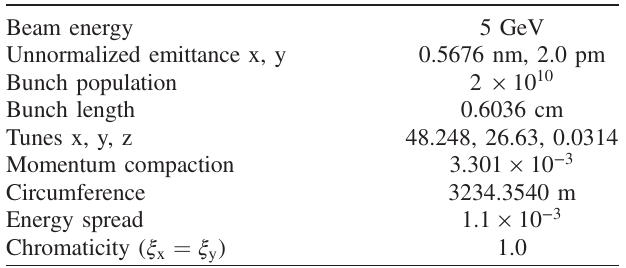
TABLE V. List of physical parameters used in the CMAD simulations, corresponding to the ILC DR lattice design.